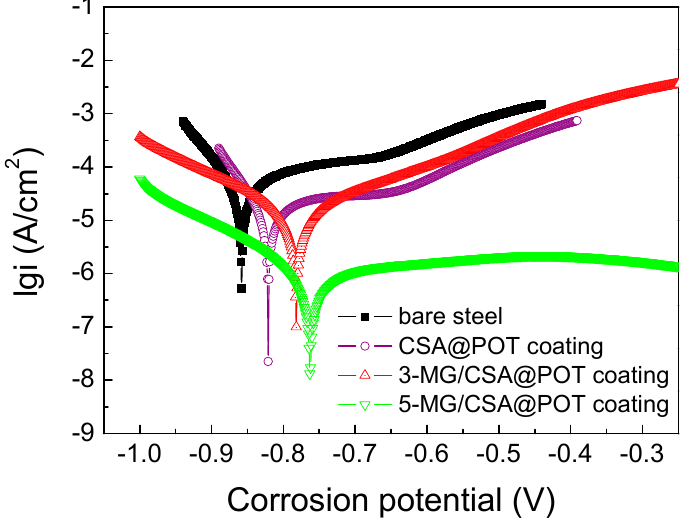
Figure 5. Potentio-dynamic polarization curves for the bare steel ( a ), CSA@POT coating ( b ), 3-MG/CSA@POT coating ( c ), and 5-MG/CSA@POT coating ( d ) in a 3.5% NaCl solution.